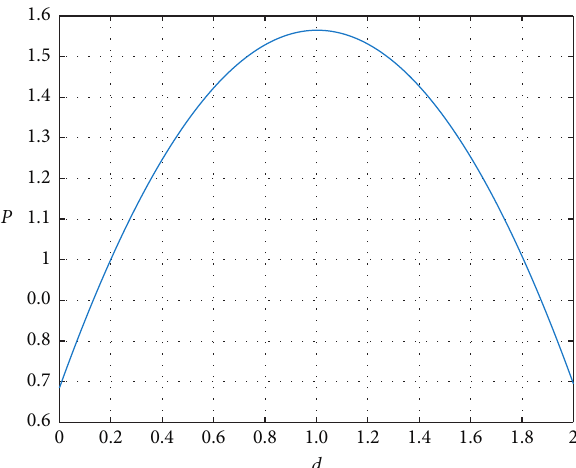
Figure 3: Relationship between the relationship leadership coef- ficient d and leadership effectiveness P .